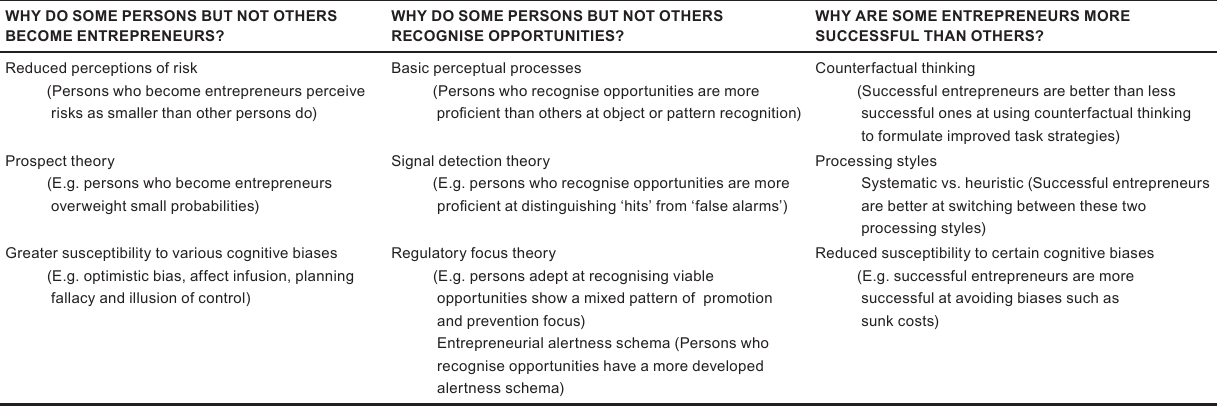
table 1 Cognitive factors relevant to issues identified in the field of entrepreneurship research